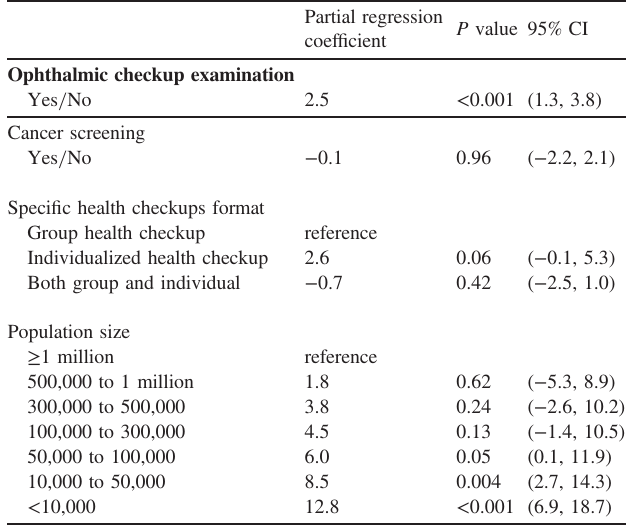
Table 3. The factors associated with the speci fi c health checkup participation rate using multiple linear regression analyses